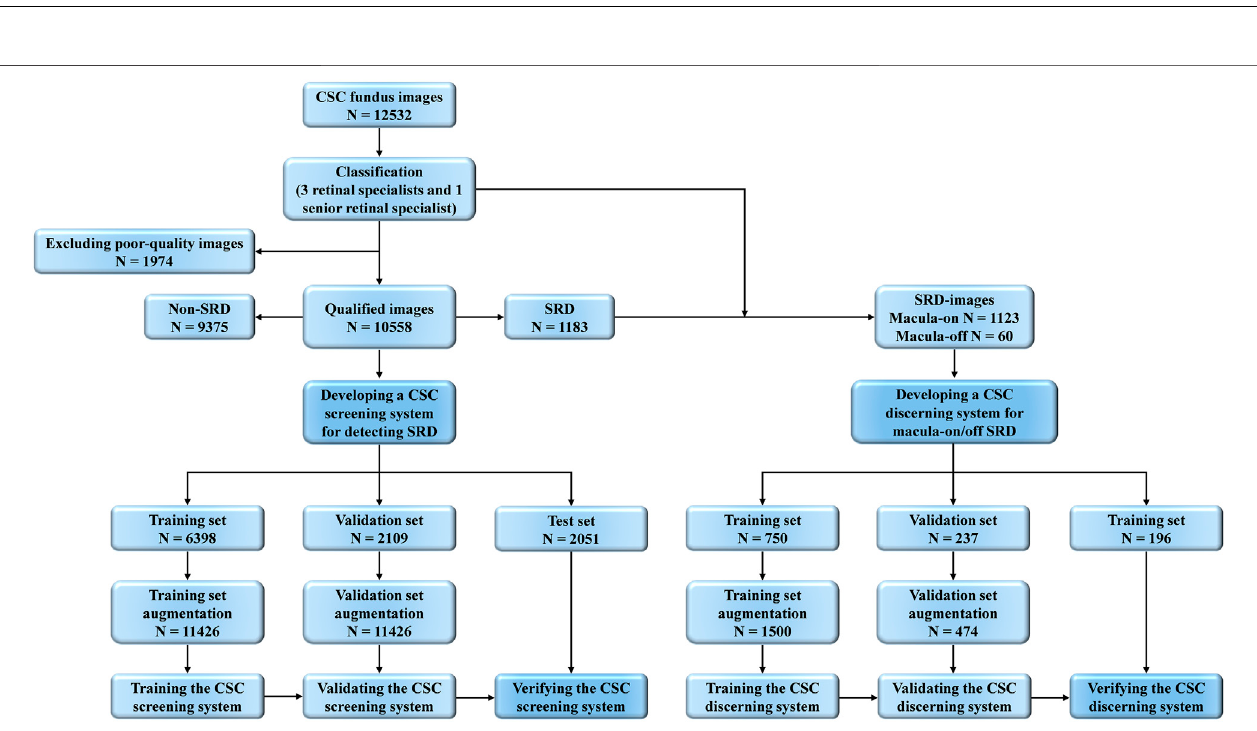
FIGURE 2 | Overall Study Work fl ow. Work fl ow of developing deep learning systems for identifying SRD and discerning macula-on/off SRD based on fundus images. SRD, serous retinal detachment; CSC, central serous chorioretinopathy.